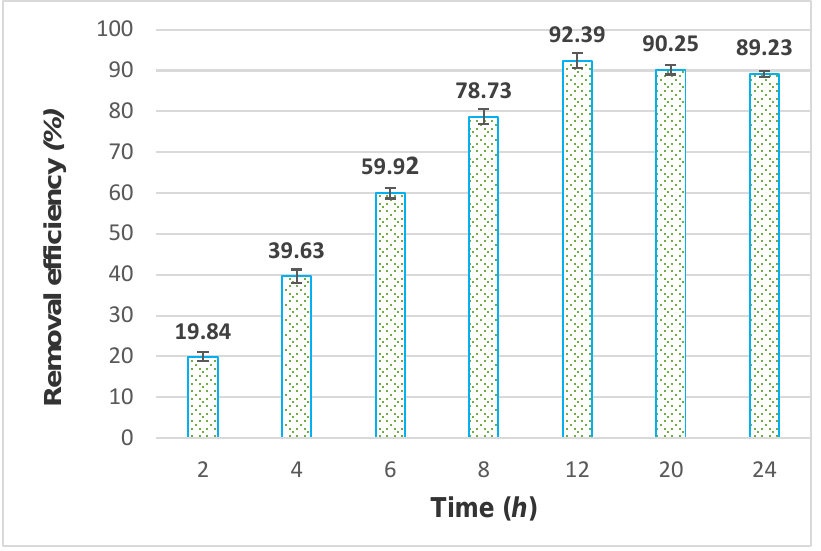
Figure 7. The effect of time on the phenol removal performance of Fe-Cu material.